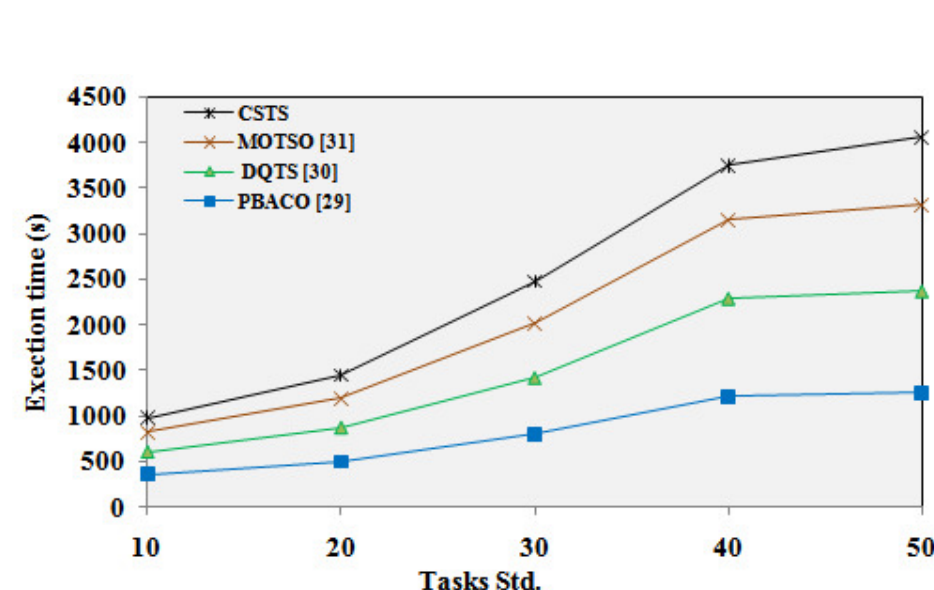
Figure 7. Execution time with task standard